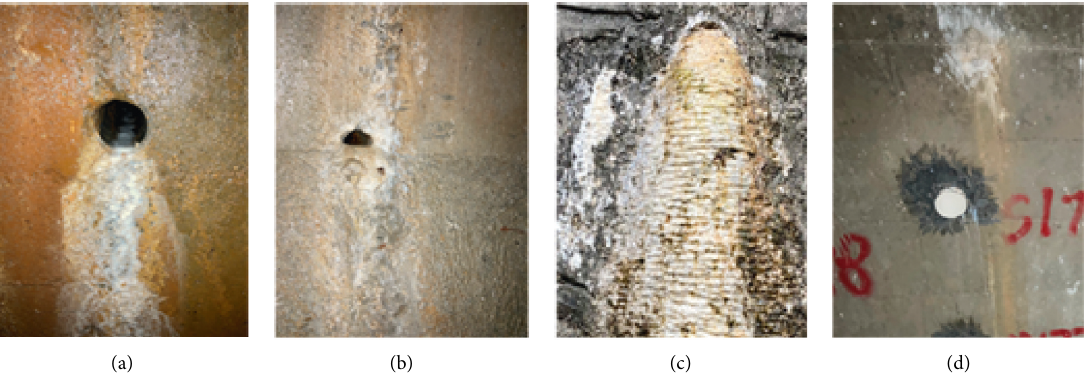
Figure 3: Drainage hole classification. (a) Slight blockage; (b) moderate blockage; (c) heavy blockage; (d) no